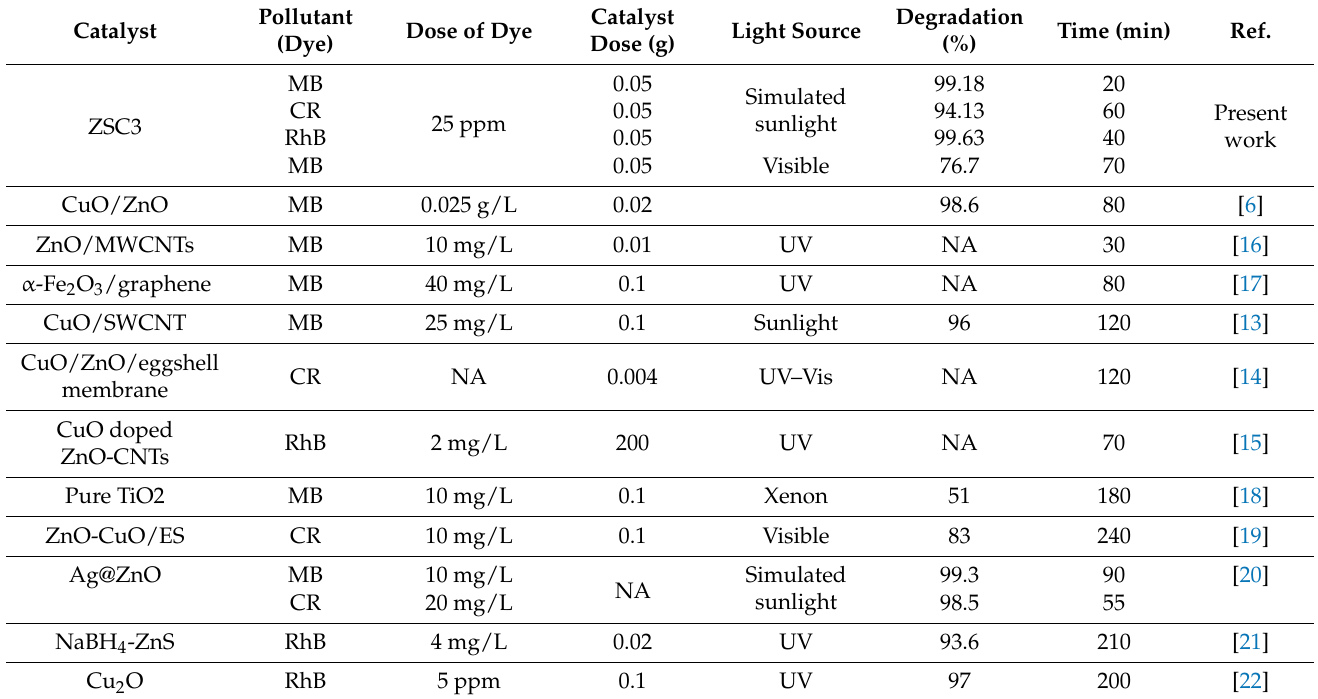
Table 2. The comparison of the photocatalytic performance of our catalyst with those of catalysts reported in the